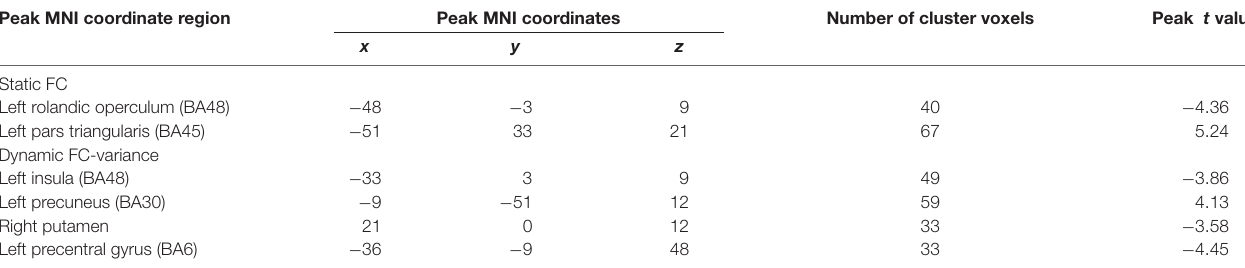
TABLE 3 | Regions showing group differences in static functional connectivity (FC) and dynamic FC with the right dorsolateral prefrontal cortex (DLPFC). Peak MNI coordinate region Peak MNI coordinates Number of cluster voxels Peak t